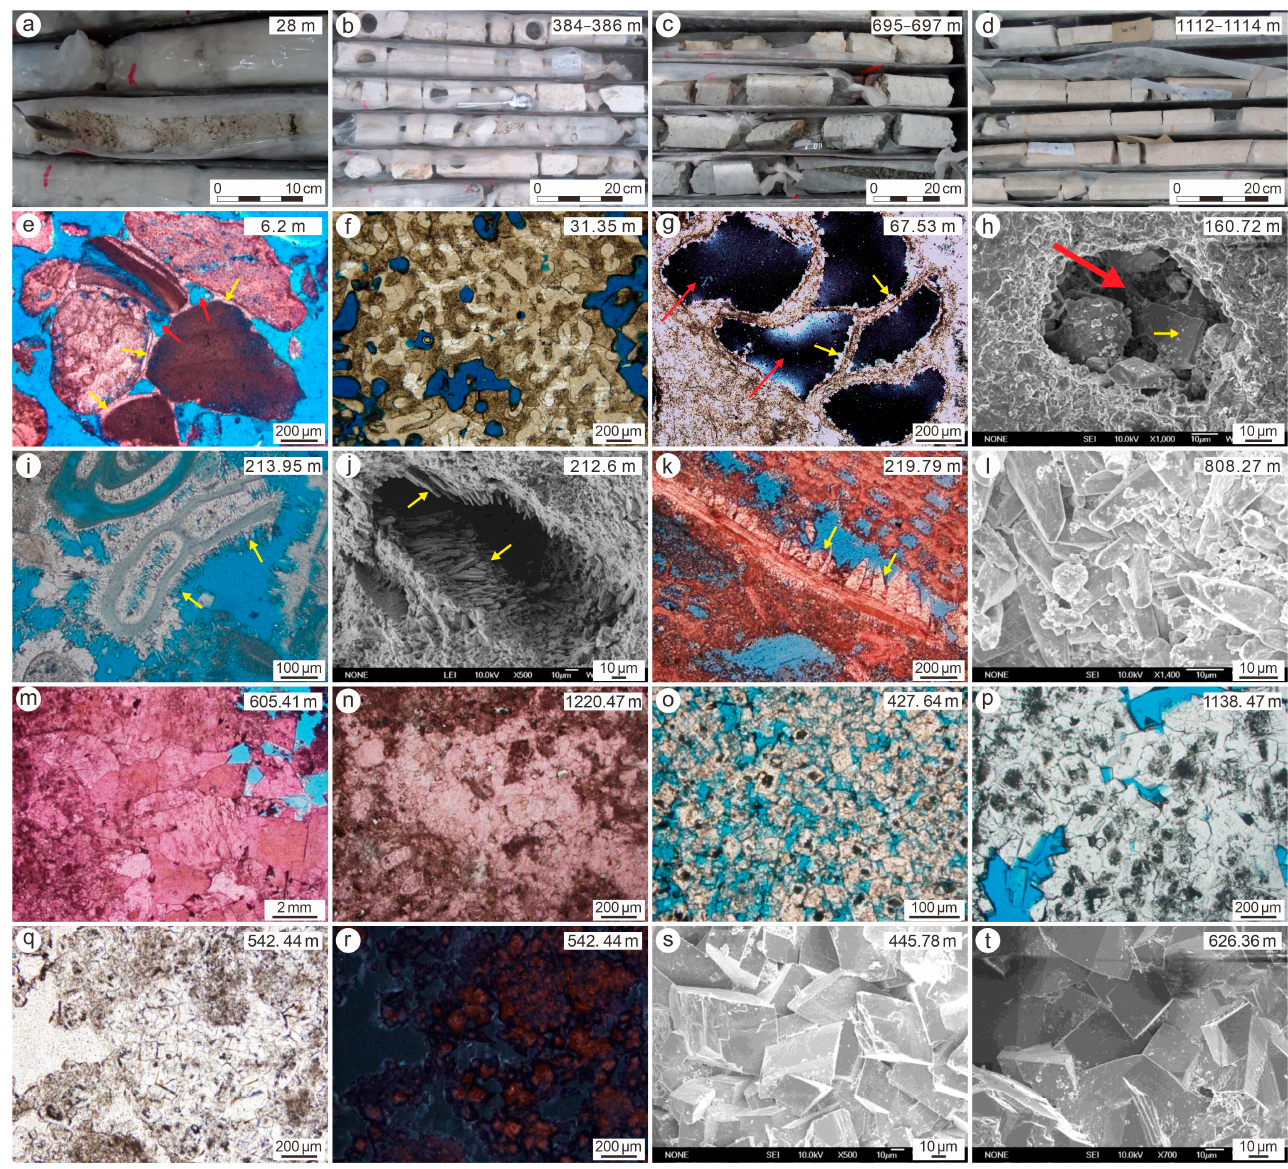
Figure 3. Photographs of core hand specimens and petrographic micrographs showing diagenetic 56 features of the XK-1 core carbonates. ( a – d ) Photographs of core hand specimens at different depths 57 (28 m, 384–386 m, 695–697 m, 1112–1114 m). ( e – h ) Typical products of meteoric diagenesis. ( e ) 58 Meniscus calcite cements (yellow arrows), and rounded pores (red arrows), 6.2 m, plane-polarized 59 light, thin section stained with blue epoxy. ( f ) Neomorphism in framestone, 31.35 m, 60 plane-polarized light, stained section. ( g ) Melodic pores (red arrows) formed by dissolution, and 61 pore-filling isopachous dogtooth fringes (yellow arrows), 67.53 m, plane-polarized light, stained 62 section. ( h ) Melodic pores (red arrows) formed by dissolution, filled with fine granular rhombic 63 calcite cements (yellow arrows), 160.72 m, scanning electron micrographs (SEM photographs). ( i–l ) 64 Typical products formed under marine conditions. ( i ) Aragonite needle cements (yellow arrows) 65 around bioclastics in packstone, 213.95 m, plane-polarized light, stained section. ( j ) Circumgranu- 66 lar fibrous and bladed calcite marine cements (yellow arrows) in wackestone, 212.6 m, SEM pho- 67 tographs. ( k ) Bladed calcite cements (yellow arrows) in packstone, 219.79 m, plane-polarized light, 68 stained section. ( l ) Pore-filling bladed calcite marine cements, 808.27 m, SEM photographs. ( m,n ) 69 Typical signs of burial diagenesis. ( m ) Coarse poikilotopic blocky calcite spar, 605.41 m, 70 plane-polarized light, stained section. ( n ) Coarse poikilotopic blocky calcite spar, 1220.47 m, 71 plane-polarized light, stained section. ( o–t ) Typical products of dolomitization under stable ma- 72 rine conditions. ( o ) Dolomite rhombs with cloudy cores and clear rims, 427.64 m, plane-polarized 73 light, stained section. ( p ) Dolomite rhombs with smaller cloudy cores and larger bright exteriors, 74